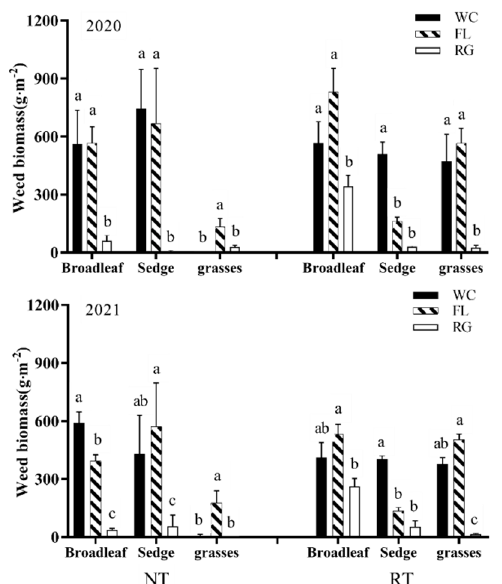
Figure 3. The impact of different cover crops and tillage methods on the biomass of weeds of different species. NT, no − tillage; RT, rotary tillage. Different letters at the top of the bar chart denote significant differences among different treatments of cover crops for the same tillage method and weed species at p < 0.05 by LSD test. The bar represents mean values of 4 replicates ± SD.